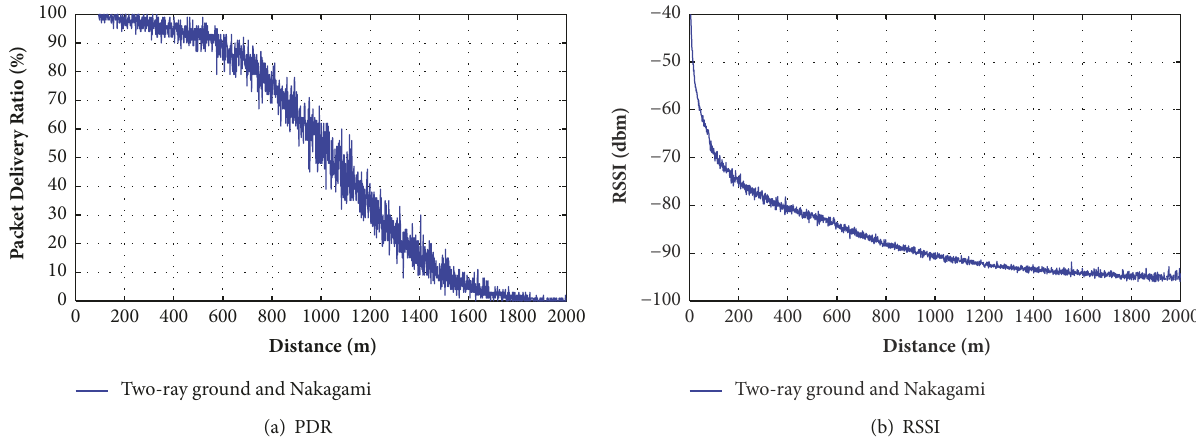
Figure 10: Simulation results when applying two-ray ground model coupled with Nakagami model. (a) PDR. (b) RSSI.